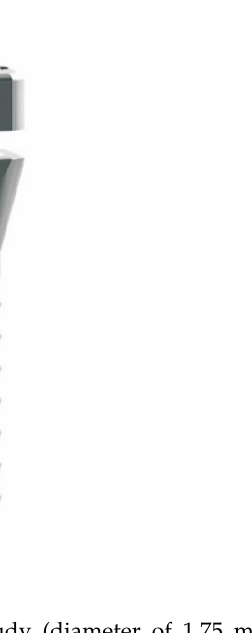
Figure 1. Self-drilling miniscrews used in the study (diameter of 1.75 mm, length of 8 mm, and high head).